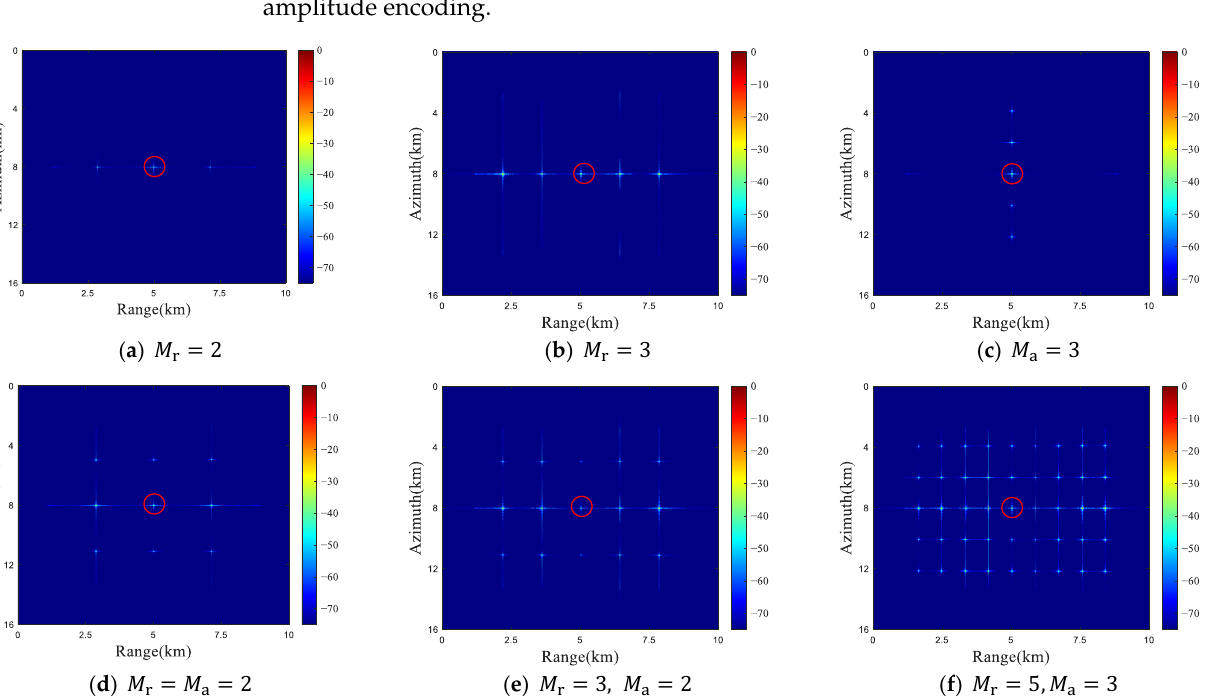
Figure 9. Simulation results of point targets with different grouping numbers (without amplitude encoding), where the real target is inside the red circle. Results with only intra-pulse encoding ( a ) 𝑀 r = 2, ( b ) 𝑀 r = 3 , and ( c ) results with only inter-pulse encoding ( 𝑀 r = 3 ). Results with intra-pulse and inter-pulse encoding ( d ) 𝑀 r = 𝑀 a = 2 , ( e ) 𝑀 r = 3,𝑀 a = 2 , and ( f ) 𝑀 r = 5, 𝑀 a = 3 .